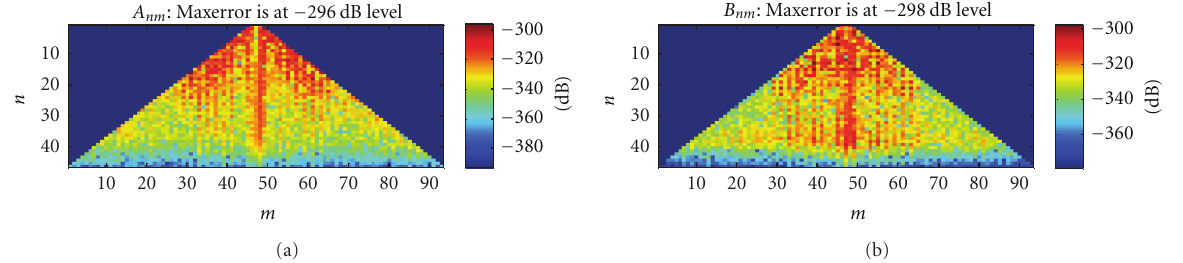
Figure 5: Error plots of the spherical expansion coe ffi cients computed from the higher-order probe output with ψ = 2 ◦ without truncating and (b) is E (46) . the M matrix. (a) is E (46) A nm B nm